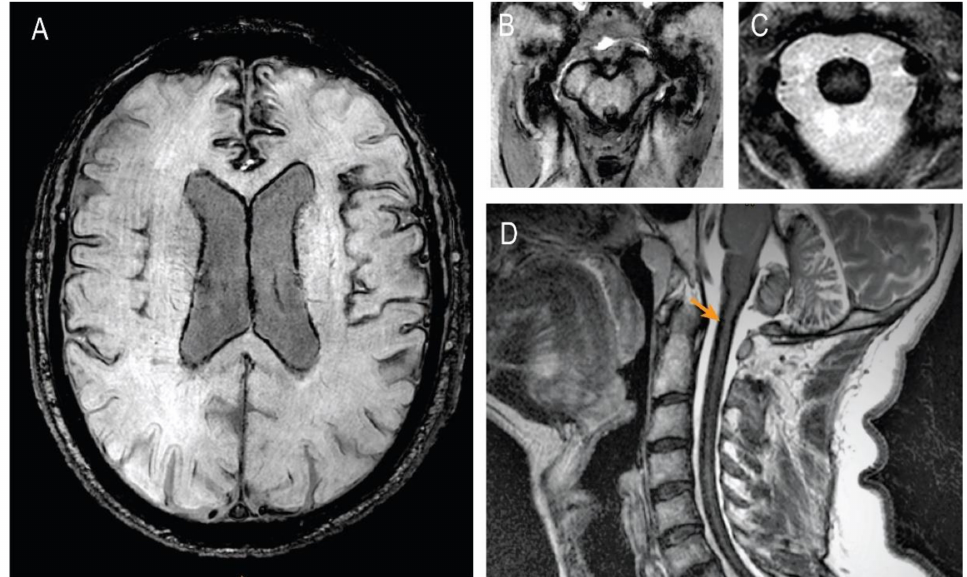
Figure 2. Follow-up brain and spinal MRI showing severe SS-CNS. ( A ) Susceptibility weighted transverse image SWI showing severe cortical and periventricular SS; ( B ) SWI of mesencephalic structures; ( C ) SWI of cervical spinal cord; ( D ) T2-weighted gradient-echo sagittal images of cervical spinal cord showing severe spinal